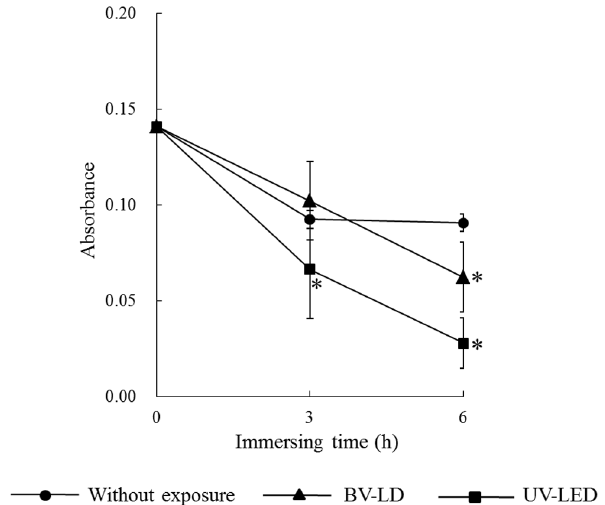
Figure 5. Changes in the absorbance of methylene blue staining for each specimen after titania treatment.